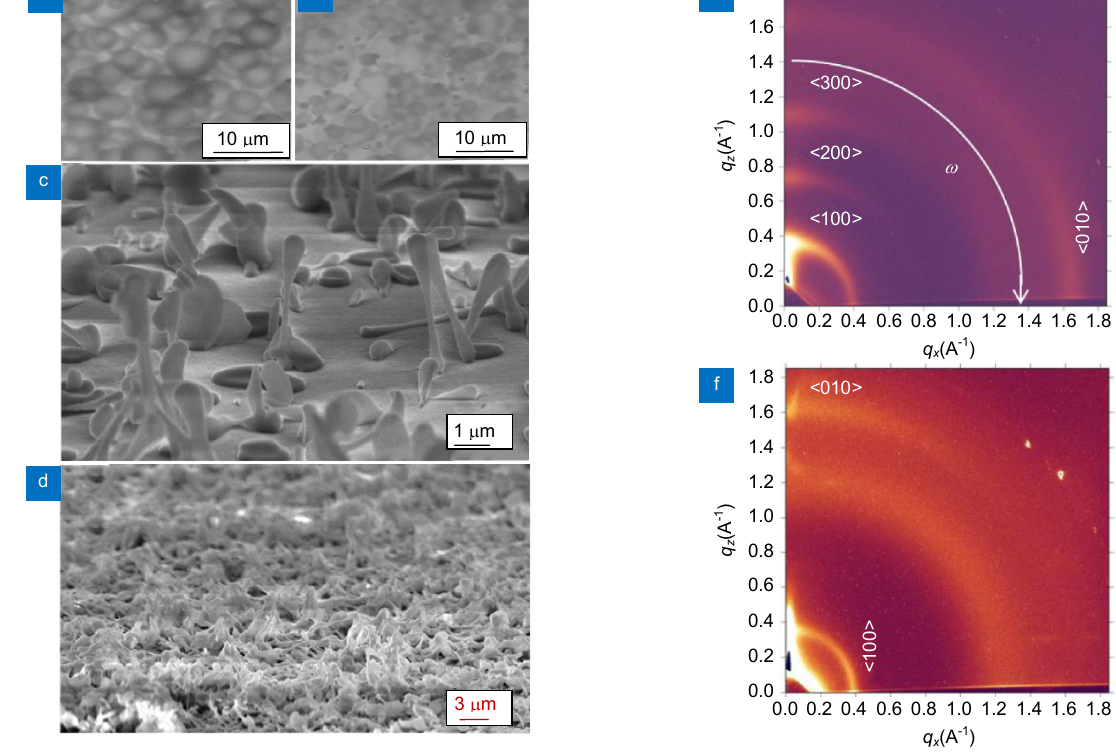
Fig. 8 | SEM images of electrosprayed P3HT films fabricated with different h . (a) Low deposition density at 15.9 mm. (b) 19.6 mm and (c) 23.2 mm. (d) High deposition density at 23.2 mm. (e) GIXRD plot of a spin-cast P3HT film. (f) GIXRD of electrosprayed P3HT film for h = 23.2 mm 35